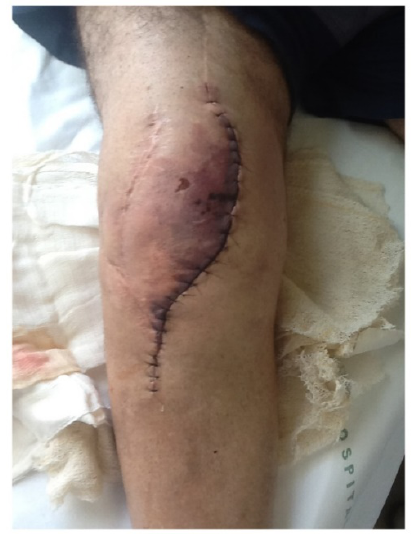
Figure 1. Wound on 5th day post-op of TKA